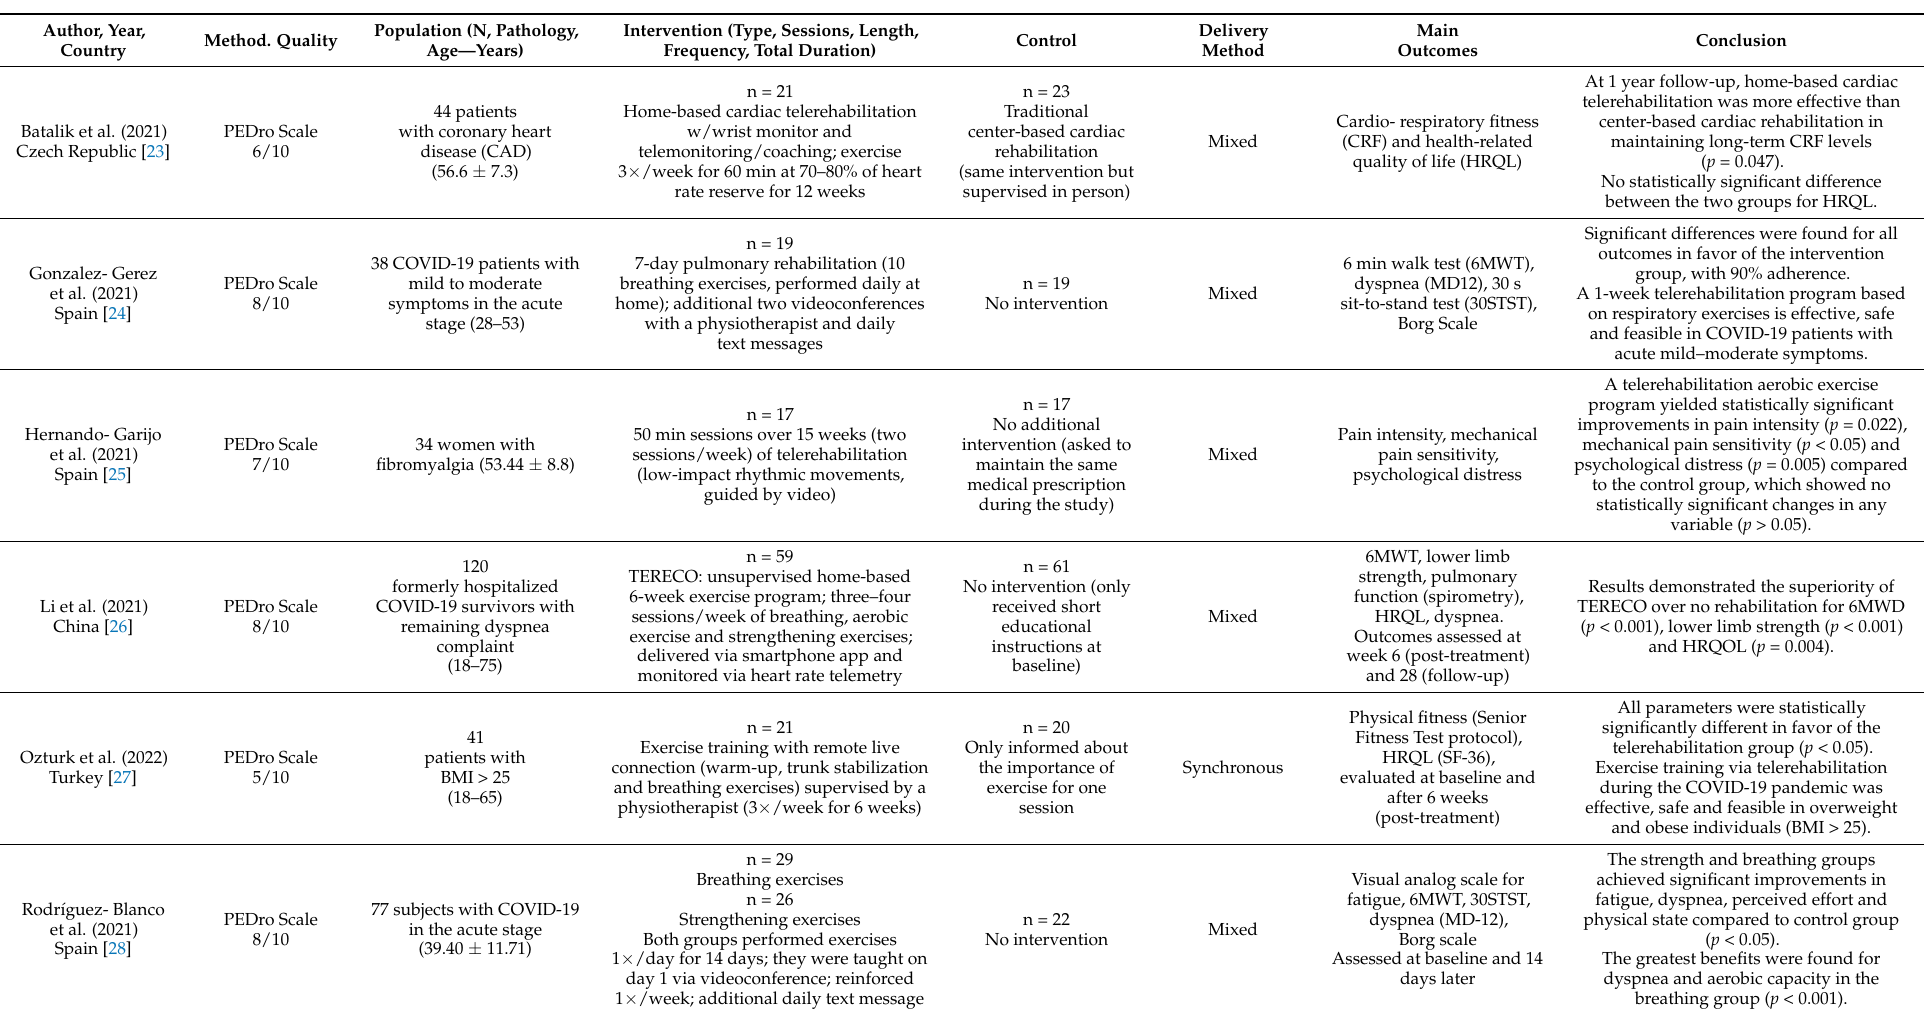
Table 1. Characteristics of the RCTs included in the